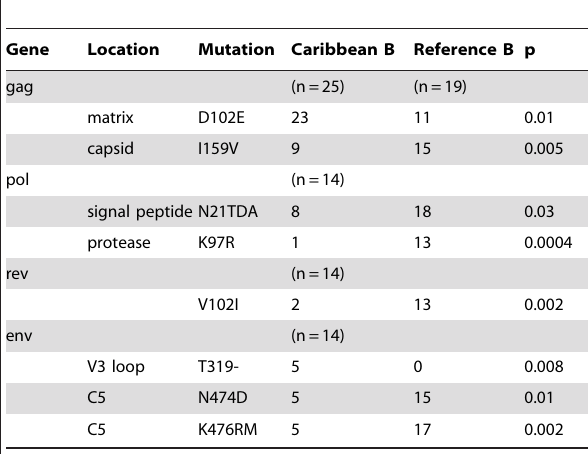
Table 1. Amino acid sites that differ between the Caribbean B strains and the subtype B reference